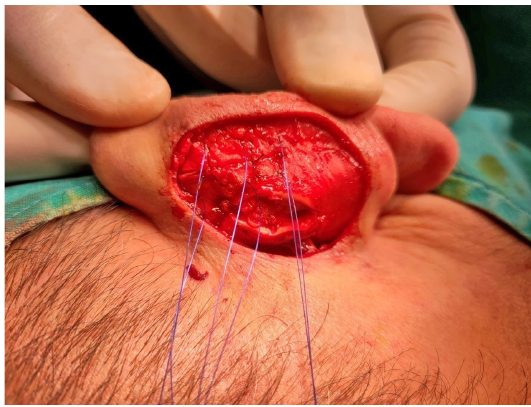
Table 1. Demographic and Clinical Characteristics of the Cases Demographic and Clinical Characteristics Average age and range (years)